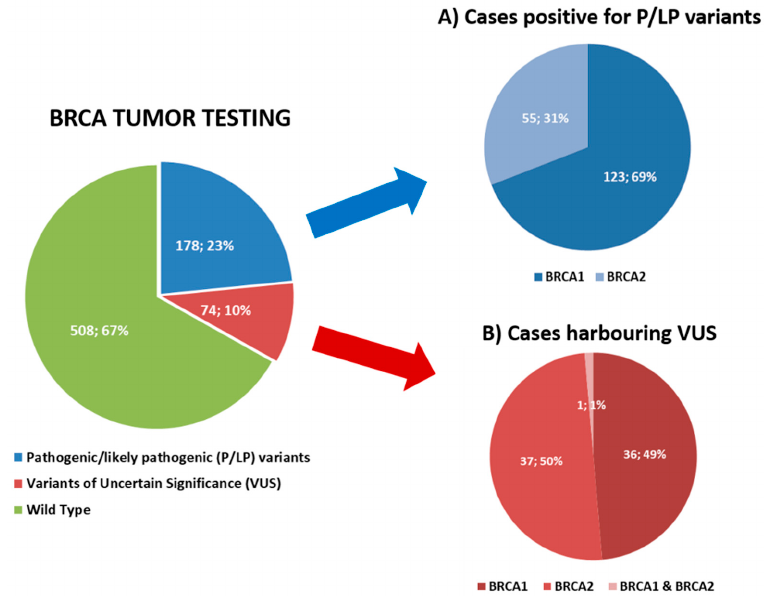
Figure 1. BRCA tumor testing results. Pie charts representing BRCA tumor testing results (number of cases; percentage). Distribution of cases harboring pathogenic/likely pathogenic variants ( A ) and variants of uncertain significance ( B ) affecting BRCA1 and BRCA2 genes.